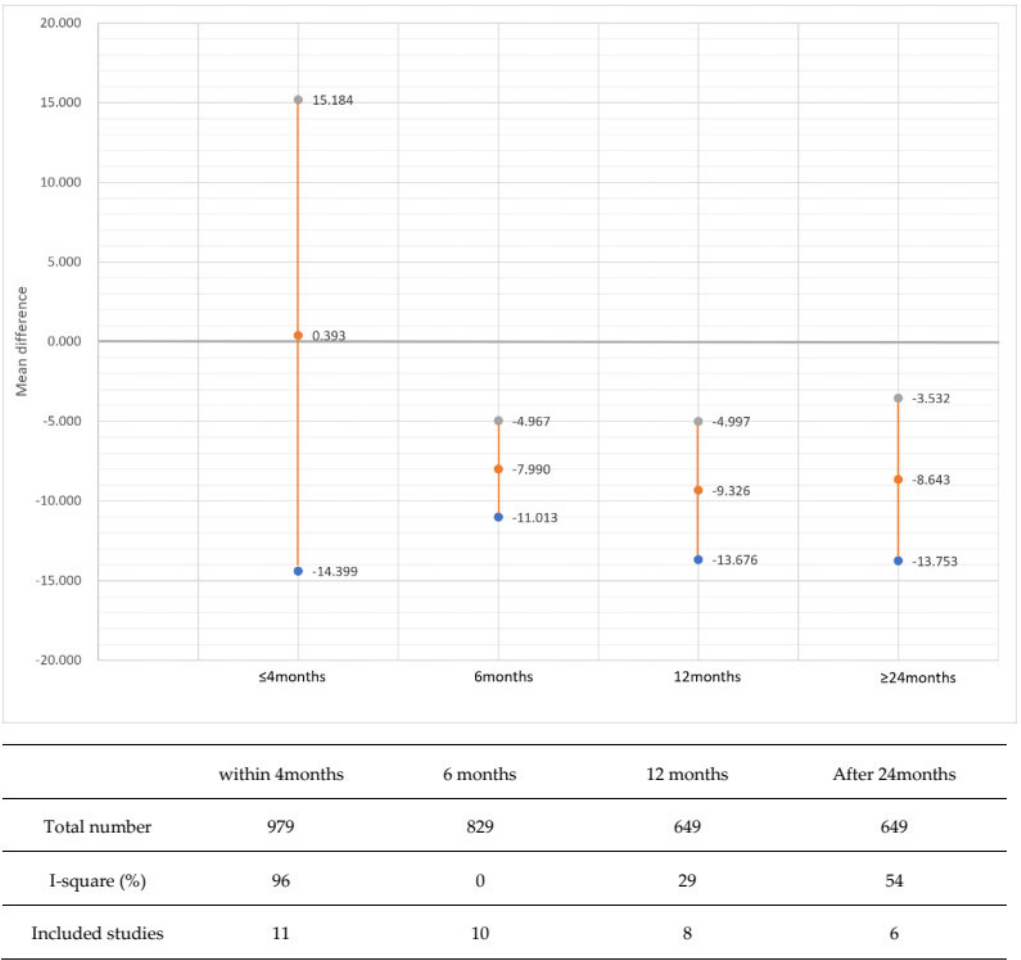
Figure 3. Subgroup analysis according to duration of topical prostaglandin analogue treatment. Table 2. Frequency of severe events after 12 months of PGA medication in two studies reporting severe events.